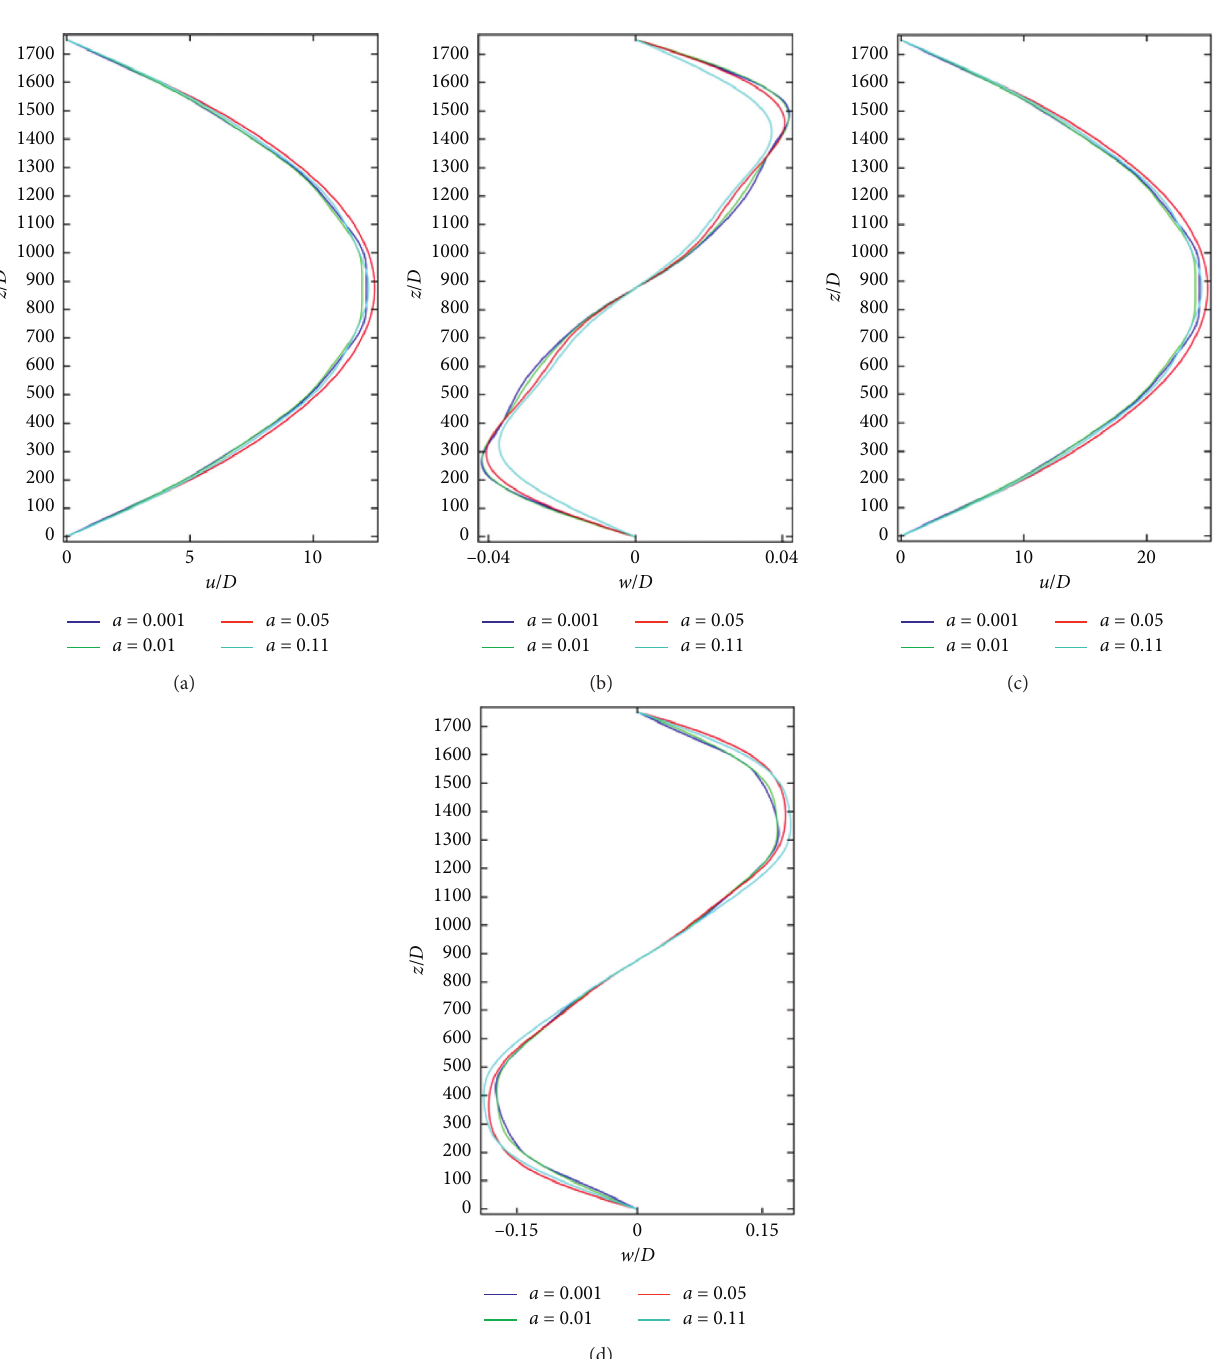
Figure 6: The influences of the viscoelastic coefficient on average displacement at different sea water velocities. (a) and (b) With U � 0.3m/s; (c) and (d) with U �